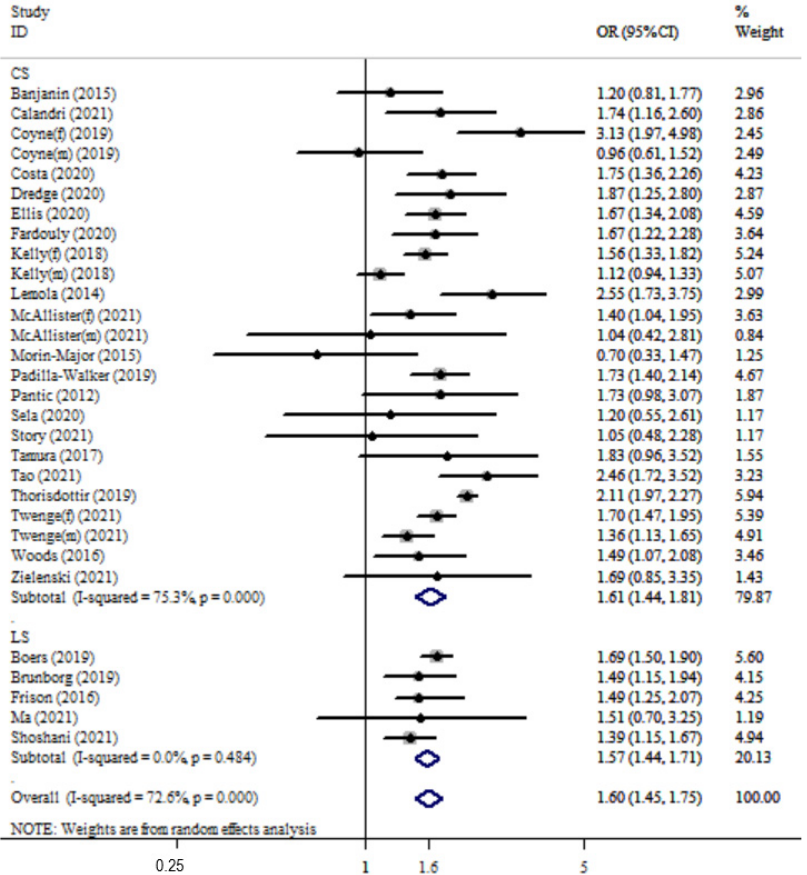
Figure 2. Forest plot of the association between time spent on social media (hours/day) and risk of depression in adolescents by study design. OR of depression for higher daily time using social media compared with reference groups and corresponding 95%CI. CS, cross-sectional; LS, longi- tudinal; f, female; m, male. Subgroup analyses show that the association between TSSM and risk of depression was moderated by gender and the measure of depressive symptoms (see Table 2).